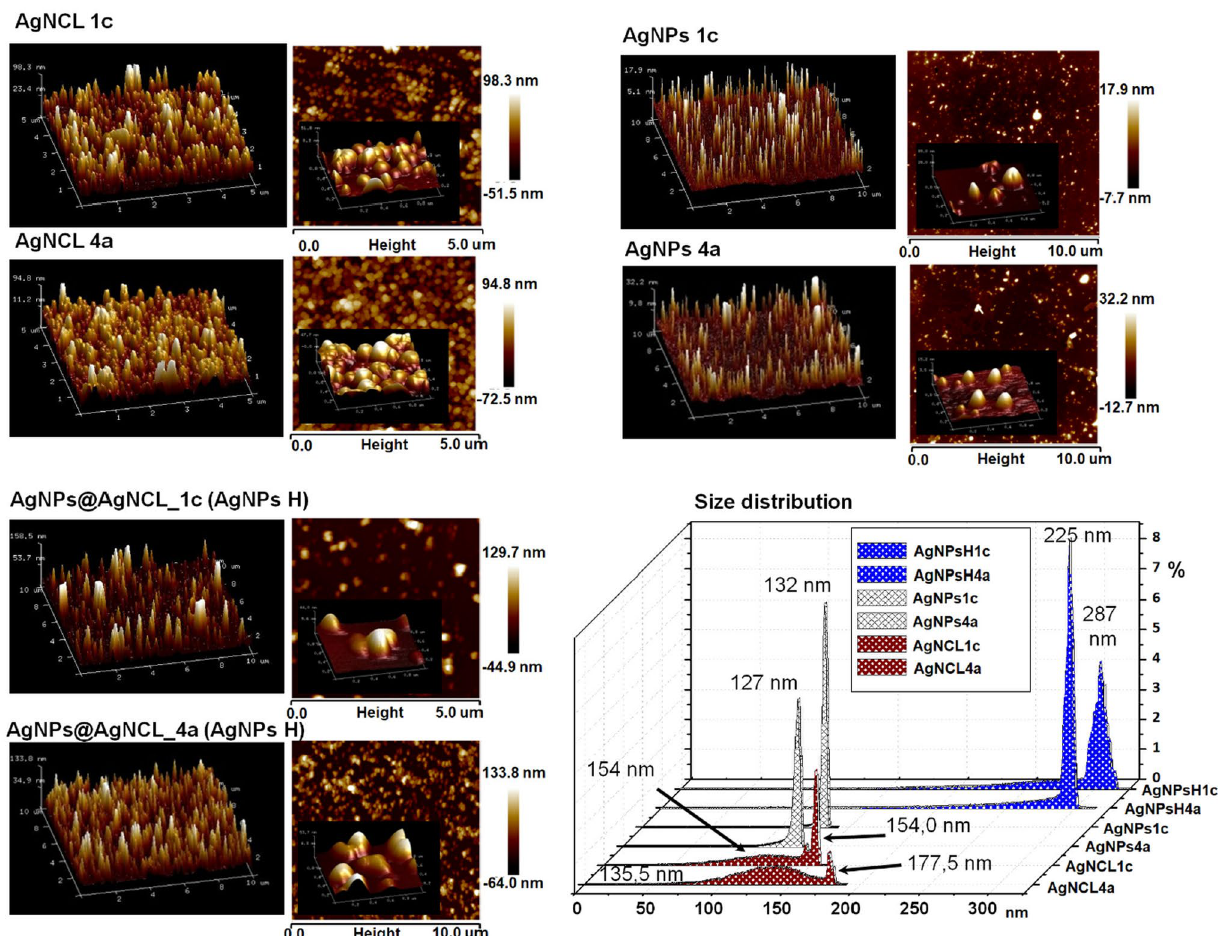
Fig. 6 AFM 2D and 3D imaging illustrating topographic information regarding the surface structure and the evaluation of the roughness for all mediated (Bio)NCs